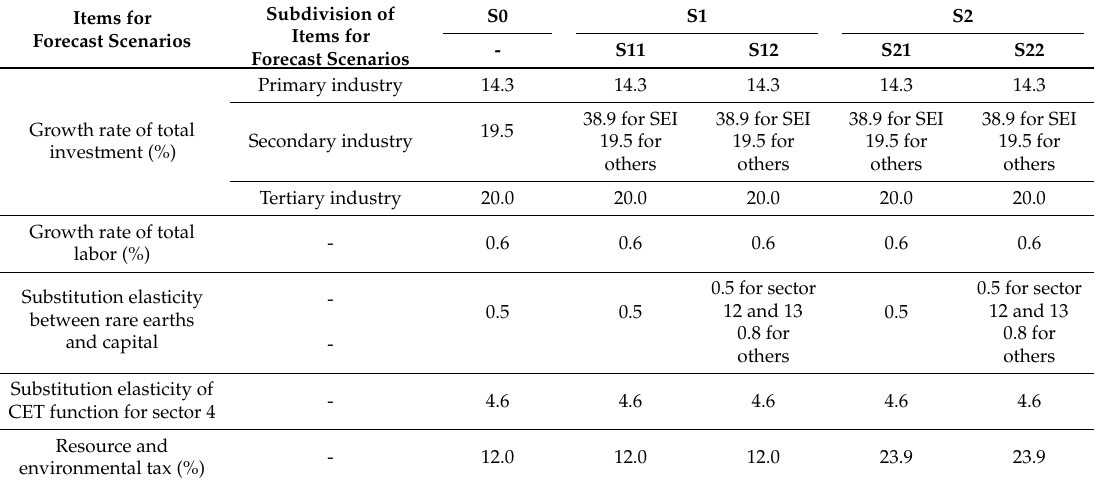
Table 3. Forecast